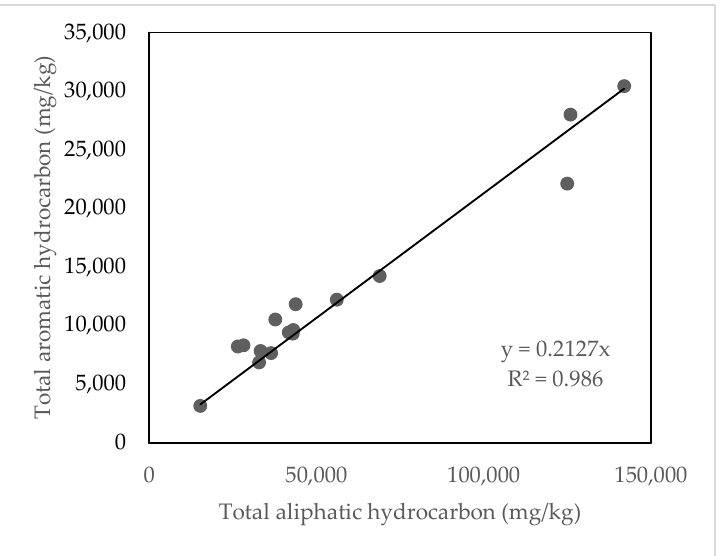
Figure 2. Relationship between the total aliphatic hydrocarbon and the total aromatic hydrocarbon in the sludge samples.